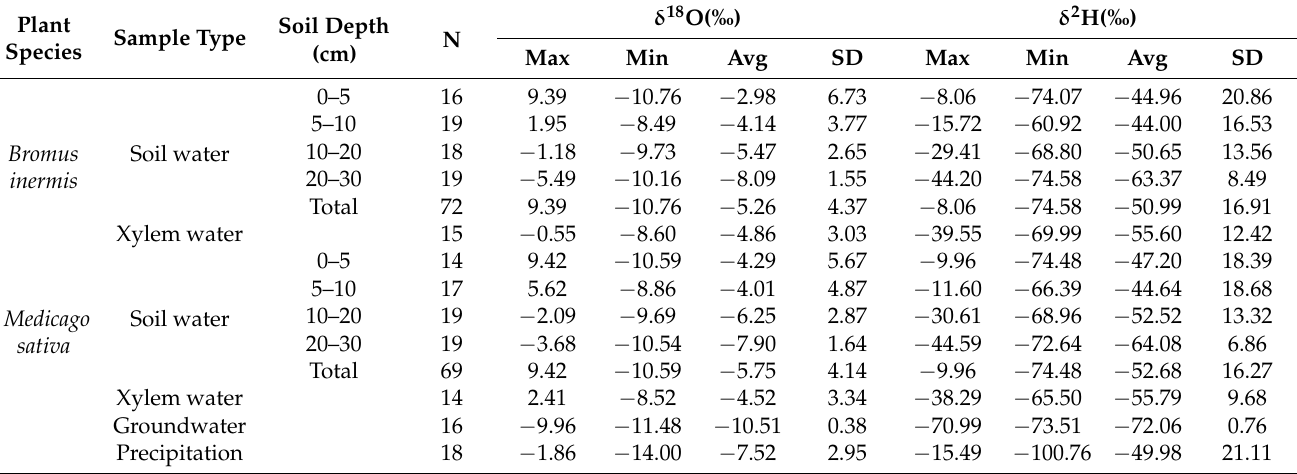
Figure 5. Results of hierarchical cluster analysis of soil volumetric water content. The white area (B) indicates the Bromus inermis grassland and the gray area (M) indicates the Medicago sativa grassland. 3.3. Isotopic Composition of Precipitation, Groundwater, Xylem Water and Soil Water The isotopic composition of precipitation showed a broad range from − 14.00 to − 1.86‰ for δ 18 O and − 100.76 to − 15.49‰ for δ 2 H, with average values of − 7.52‰ and − 49.98‰, respectively (Table 2). Compared with the global meteoric water line (GMWL) δ 2 H = 8 × δ 18 O + 10 [47], the local meteoric water line (LMWL) δ 2 H = 6.73 × δ 18 O + 0.62 (R 2 = 0.88, p < 0.01) obtained from local precipitation samples had a lower slope (6.73 V.S. 8) (Figure A1, Appendix A). However, for groundwater, the δ 18 O and δ 2 H varied within a narrower range from − 11.48 to − 9.96‰ and from − 73.51 to − 70.99‰, with average values of − 10.51‰ and − 72.06‰, respectively (Table 2; Figure 6). Table 2. General characteristics of the isotopic composition in precipitation, groundwater, soil water and xylem water samples.